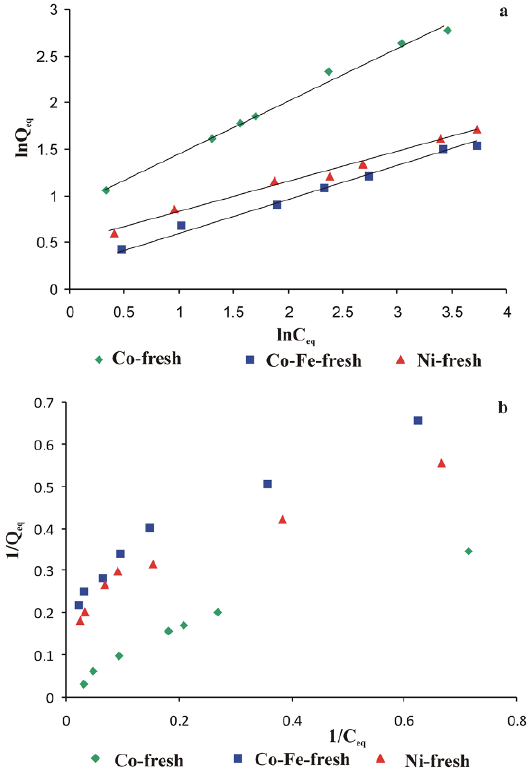
Figure 3. Freundlich (a) and Langmuir (b) plots of isotherms for methylene blue adsorption onto the investigated oxide systems (pH=10.86)